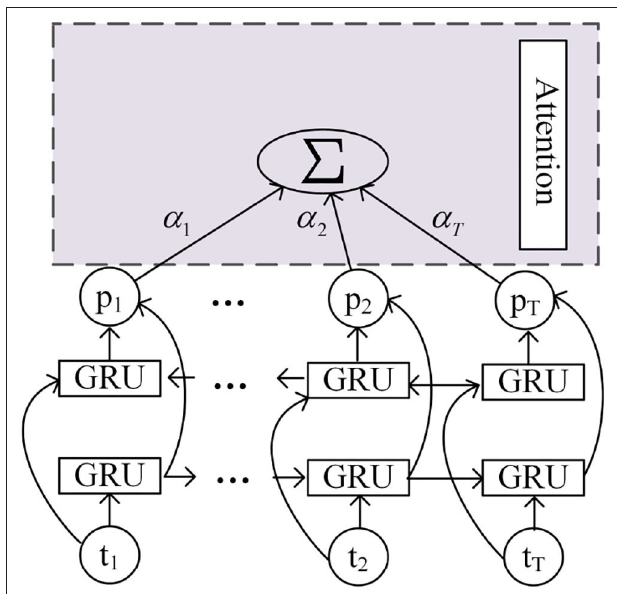
FIGURE 9 | Bi-GRU based on attention.